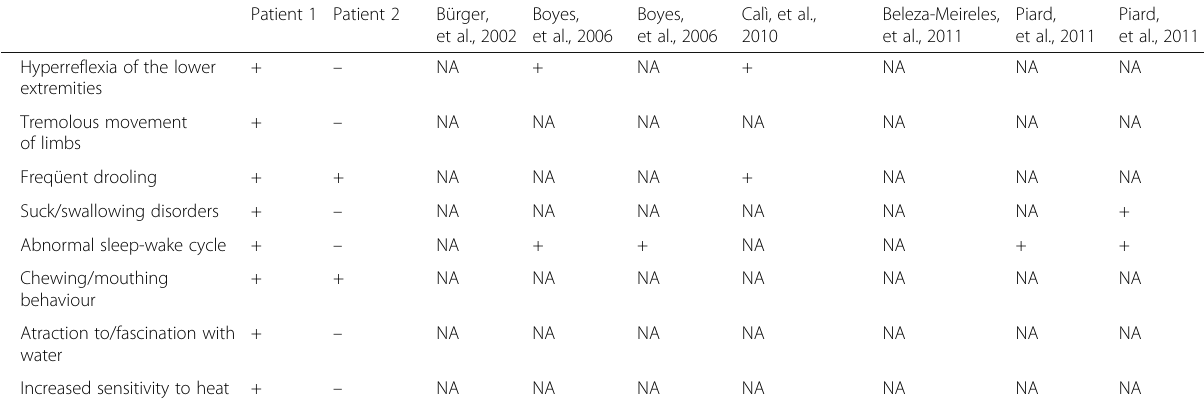
Table 1 Clinical data of patients with UBE3A intragenic deletions, following the clinical features of AS described by Williams et al., 2006